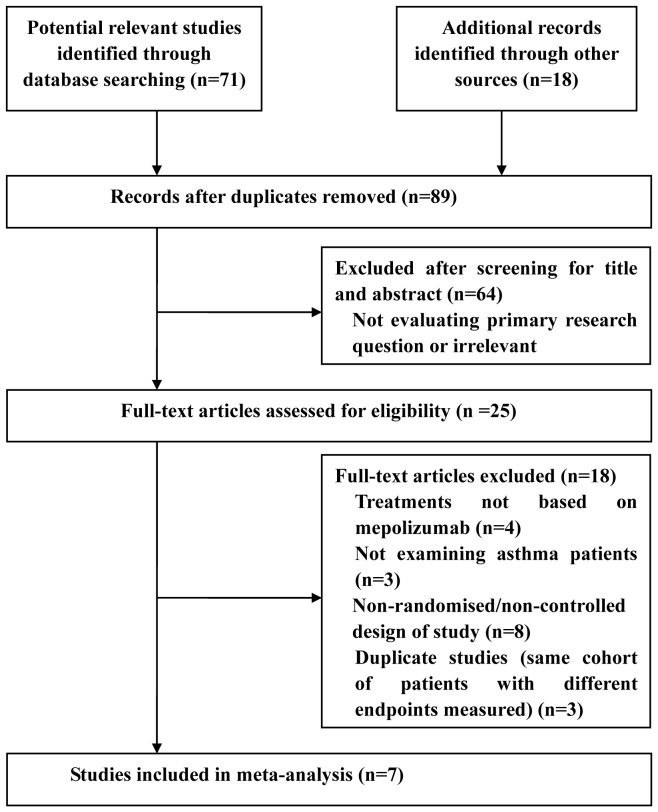
Flow of study identification, inclusion, and exclusion.